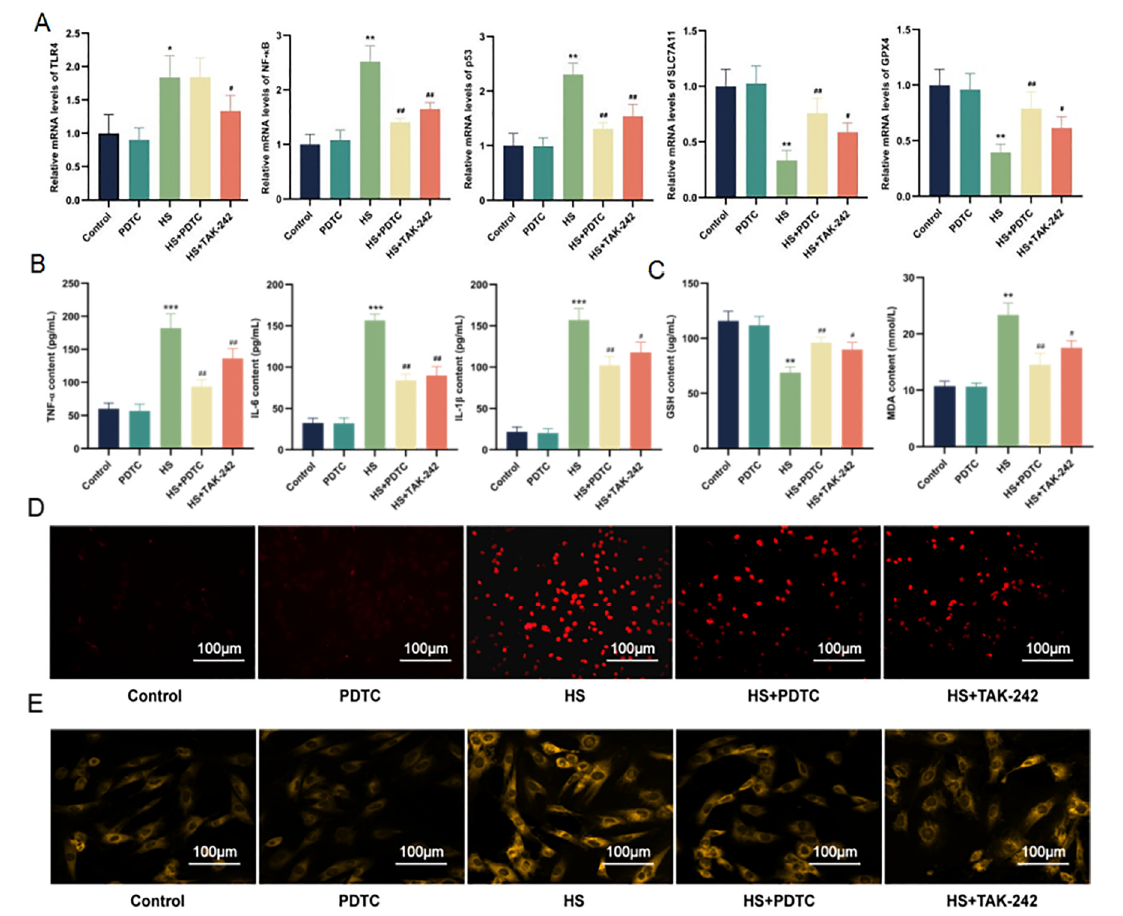
Figure 7. Inhibition of TLR4 attenuates ferroptosis by suppressing TLR4/NF- κ B signaling. The mRNA levels of TLR4, NF- κ B, p53, SLC7A11 and GPX4 in H9C2 cells were determined using RT- qPCR ( A ). TNF- α , IL-6, and IL-1 β contents in H9C2 cells ( B ). GSH and MDA contents in H9C2 cells ( C ). ROS level in H9C2 cells. Scale bars = 100 µm ( D ). Fe 2+ level in H9C2 cells. Scale bars = 100 µm ( E ). The results were expressed as the mean ± SD deviation of three independent experiments. * p < 0.05, ** p < 0.01, *** p < 0.001 vs. the control group; # p < 0.05, ## p < 0.01 vs. the HS group.